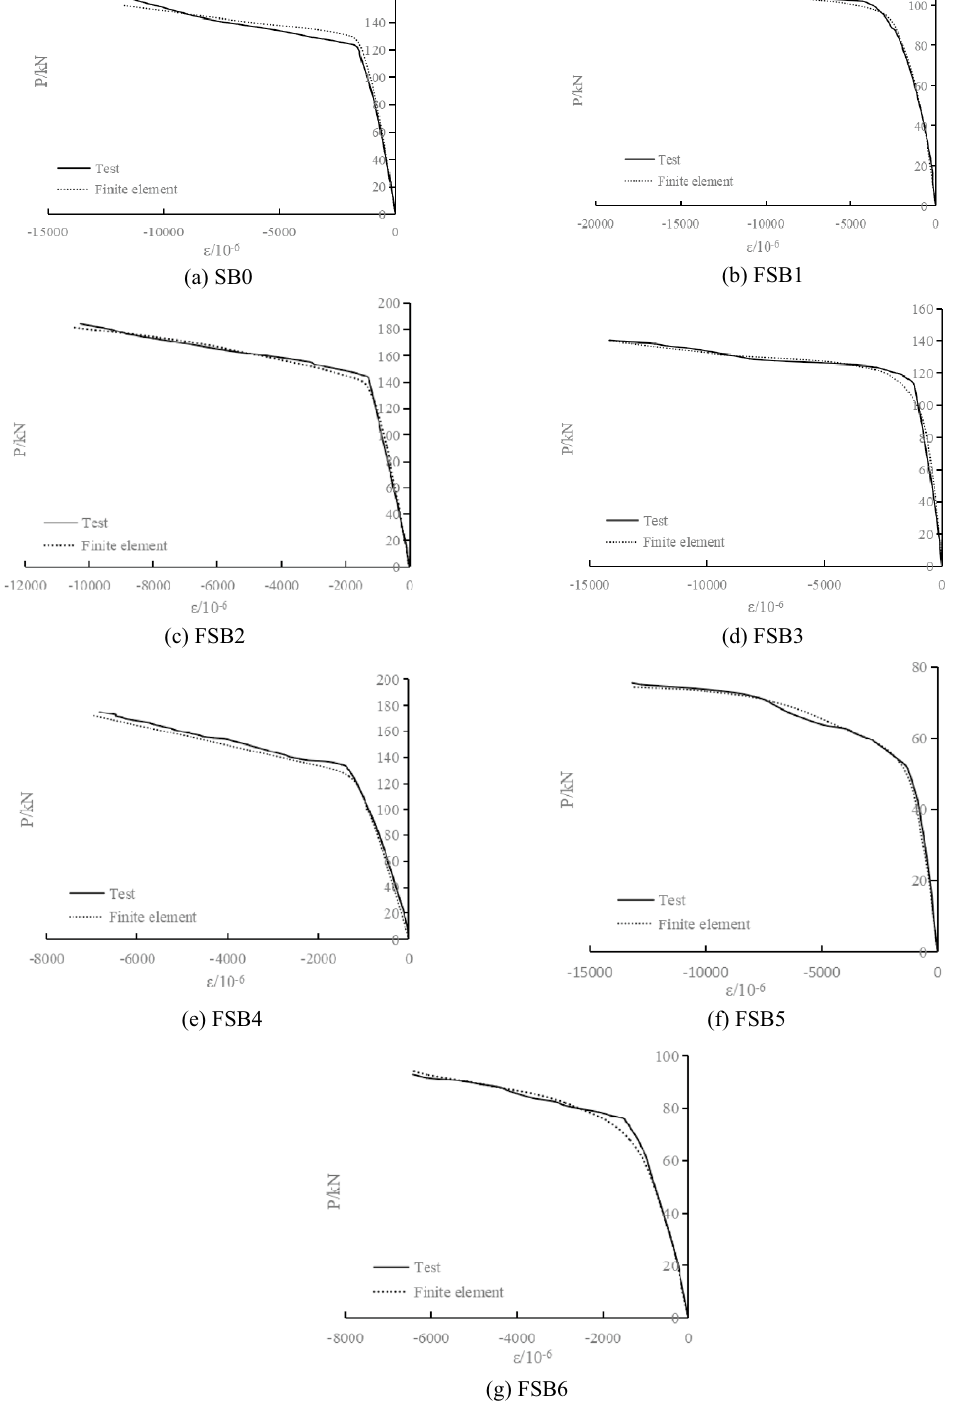
Figure 18. Comparison between test and finite element calculation of load-strain curves (compression